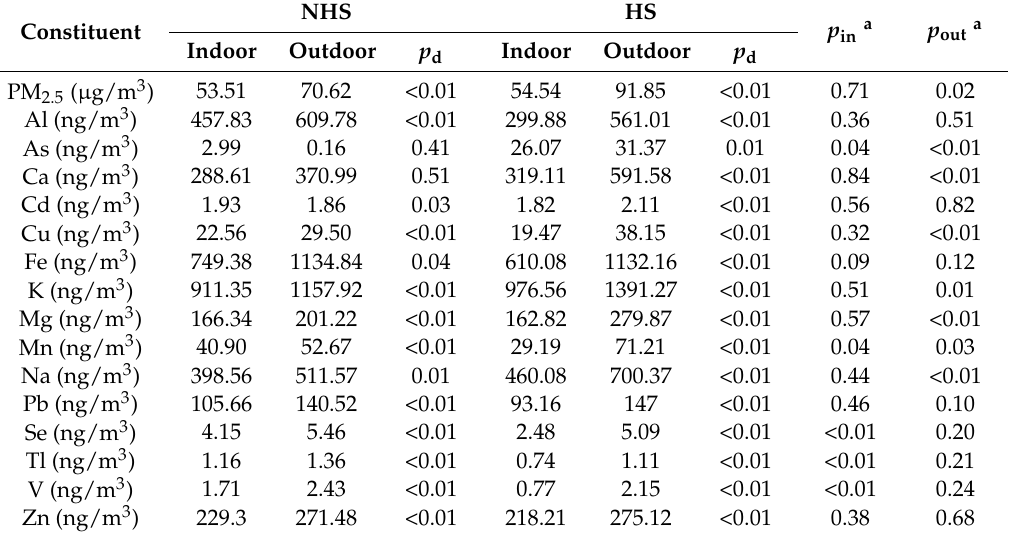
Table 5. Comparison of indoor and outdoor concentrations of PM 2.5 and elements for houses that sampled in both seasons (median, N =